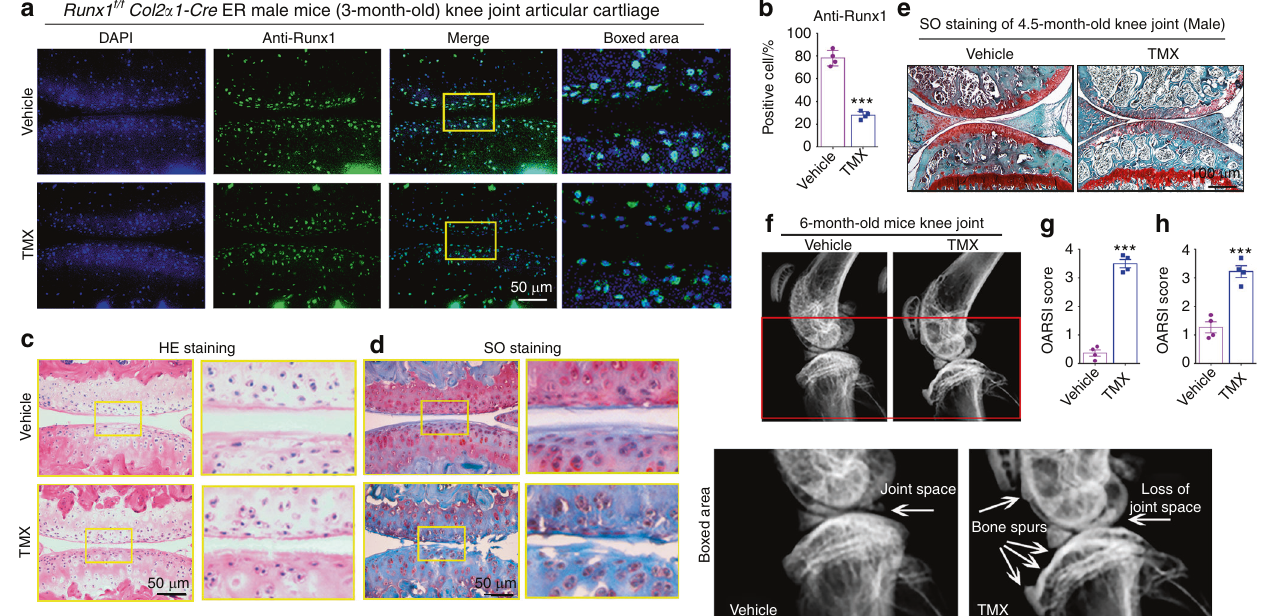
Fig. 2 Runx1 f/f Col2 α 1-Cre ER mice showed a spontaneous OA-like phenotype in vivo. a IF staining of anti-Runx1 in articular cartilage of 3-month-old male Runx1 f/f Col2 α 1-Cre ER mice induced by vehicle (control) and TMX. Bar: 50 μ m. b Quanti fi cation of ( a ). c H&E (HE) staining of 3-month-old male mice. Bar: 50 μ m. d Safranin O (SO) staining of 3-month-old male mice. Bar: 50 μ m. e SO staining of 4.5-month-old male mice. Bar: 100 μ m. f Radiographic image of 6-month-old Runx1 f/f Col2 α 1-Cre ER mice. The white arrow represents the osteophytes and a narrowed joint space. g , h Knee joint OARSI scores of ( d and e ). The results are presented as the mean ± SD, n = 4, *** P < 0.001